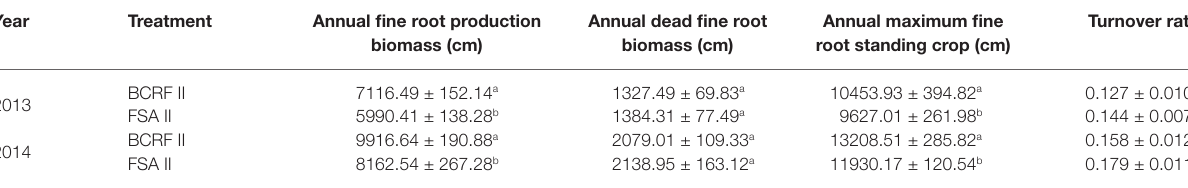
TABLE 4 | Fine root turnover rate of peach trees.